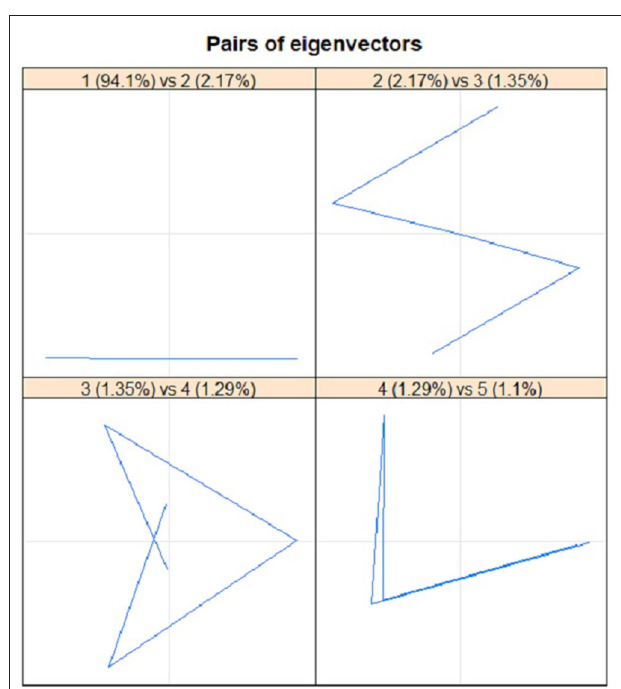
FIGURE 10 | Plots of eigenvectors (EV) pairs: 1-EV and 2-EV, 2-EV and 3-EV, 3-EV and 4-EV, as well as 4-EV and 5-EV for COVID-19 cases.